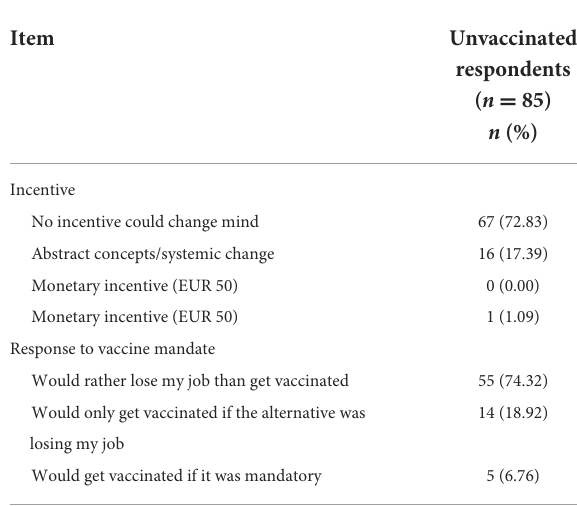
TABLE 4 Possible vaccination incentives and response to vaccine mandate.